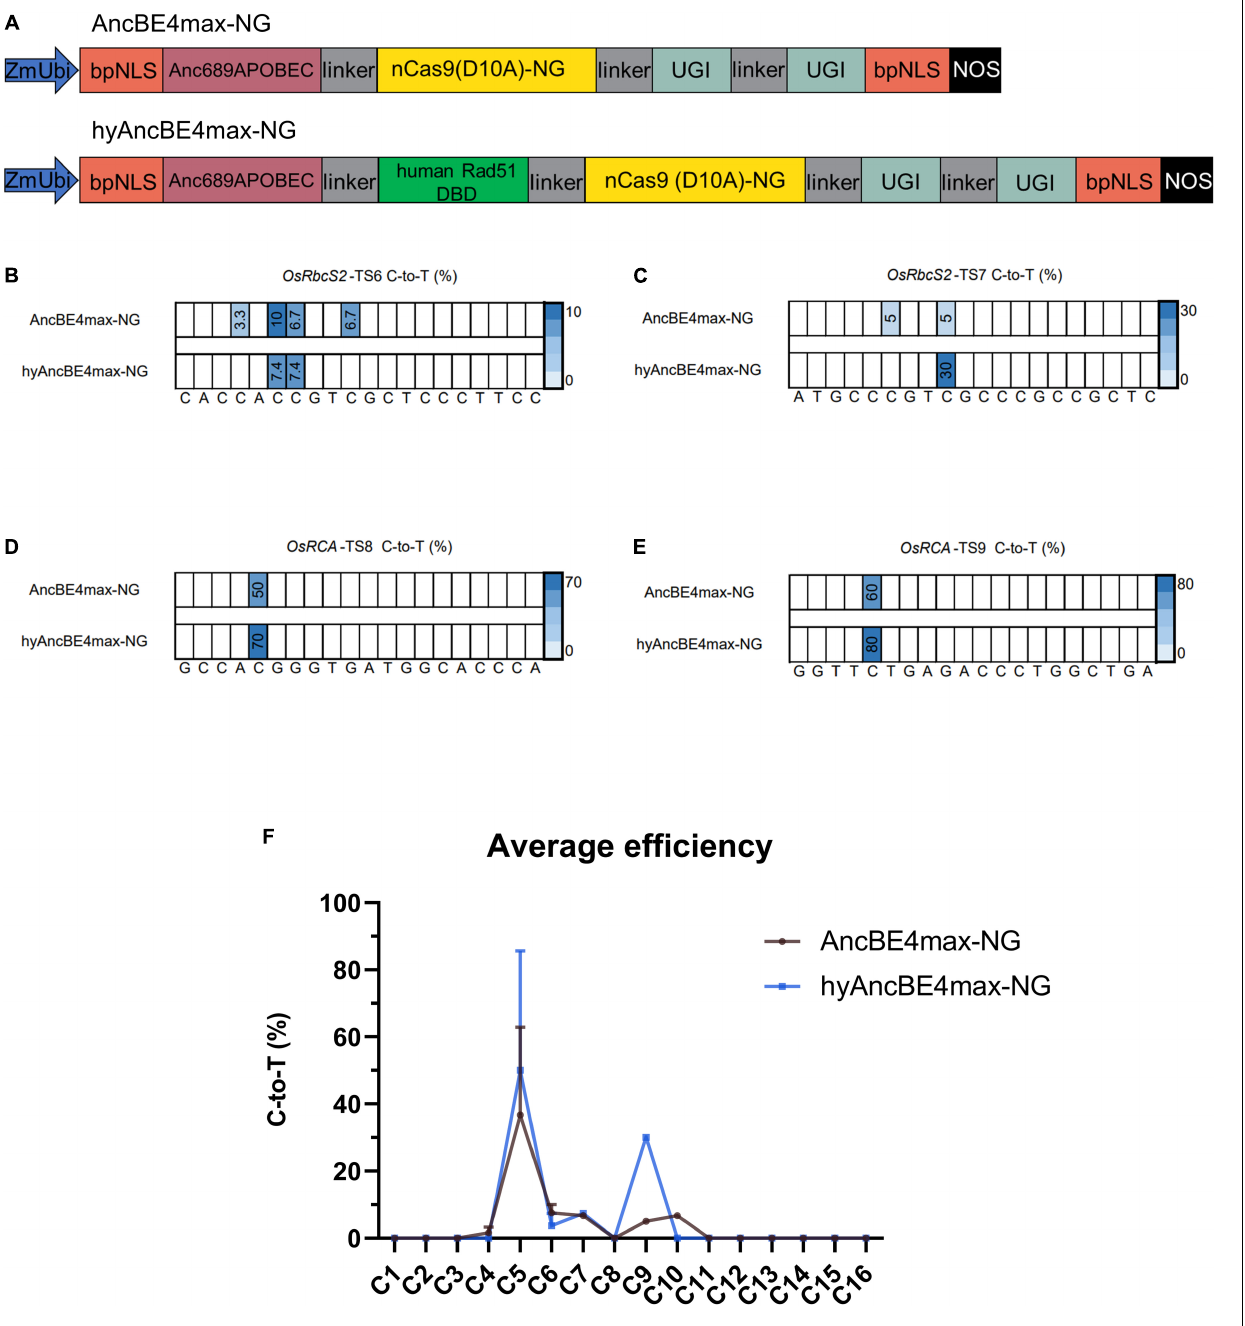
FIGURE 2 | Characterization of AncBE4max-NG and hyAncBE4max-NG in rice. (A) Schematic structures of AncBE4max-NG and hyAncBE4max-NG. The human Rad51 DBD was synthesized using a plant optimized code and cloned into AncBE4max-NG (Wang et al., 2019) to form hyAncBE4max-NG. ZmUbi, maize ubiquitin-1 promoter; bpNLS, bipartite nuclear localization signal; nCas9(D10A)-NG, nickase Cas9-NG with D10A substitution; UGI, uracil glycosylase inhibitor; NOS, NOS terminator. (B–E) C-to-T conversions of four target sites using AncBE4max-NG or hyAncBE4max-NG. (F) Average C-to-T editing efficiency for AncBE4max-NG and hyAncBE4max-NG based on all four target sites. Data are means ± SD.